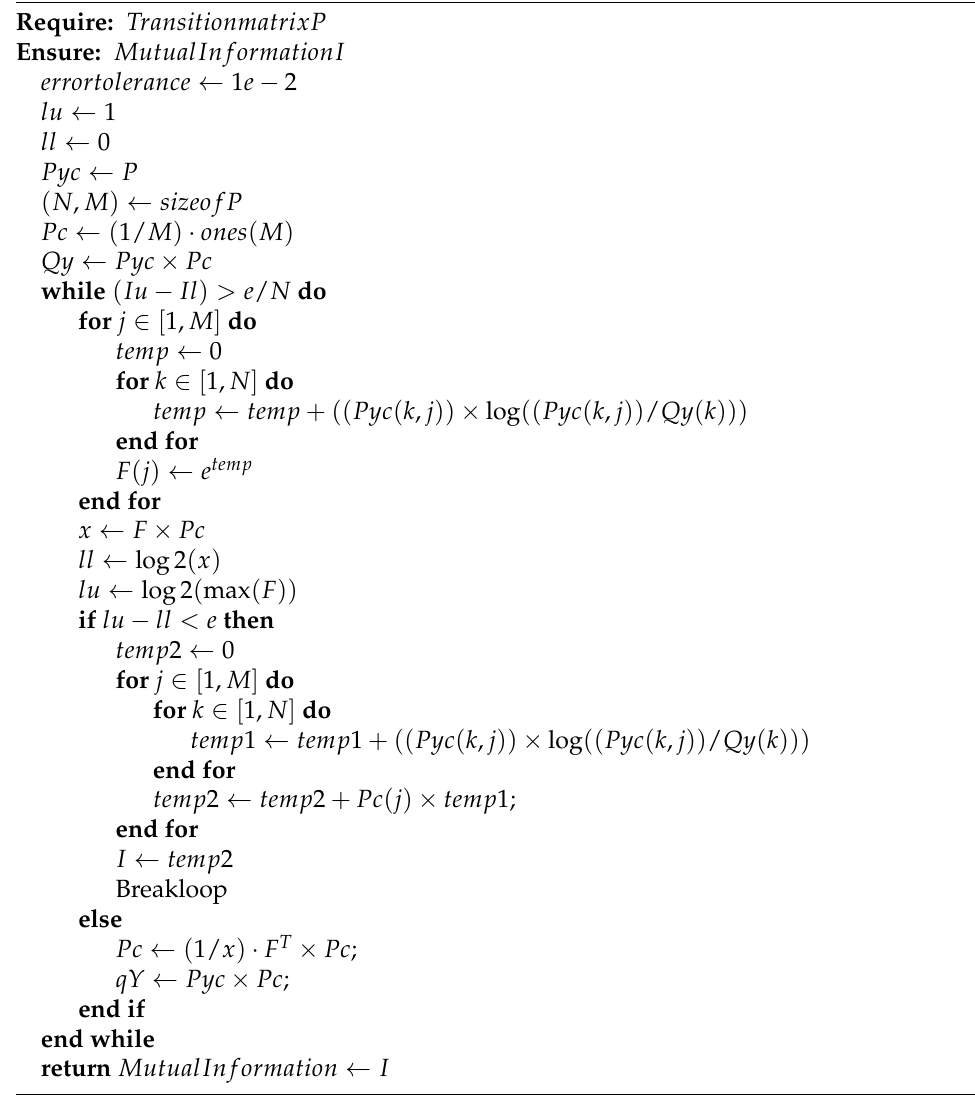
Algorithm 3 The mutual information